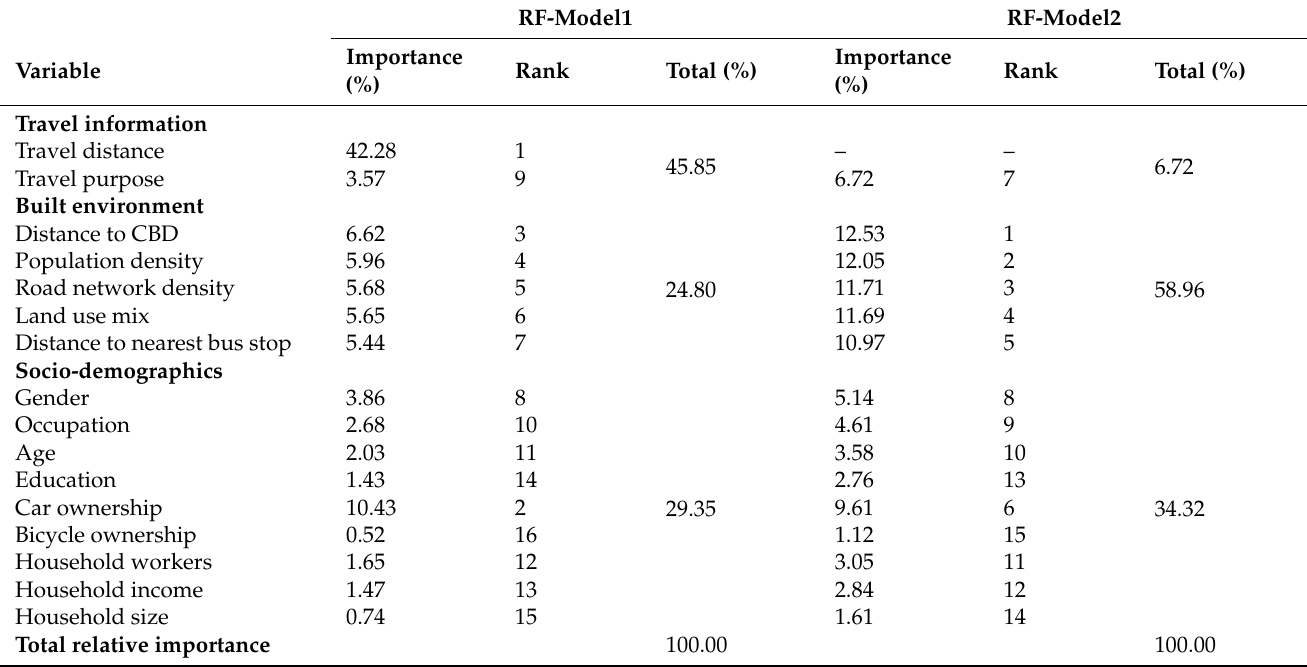
Table 3. Relative importance of feature variables (RF-Model1/RF-Model2).